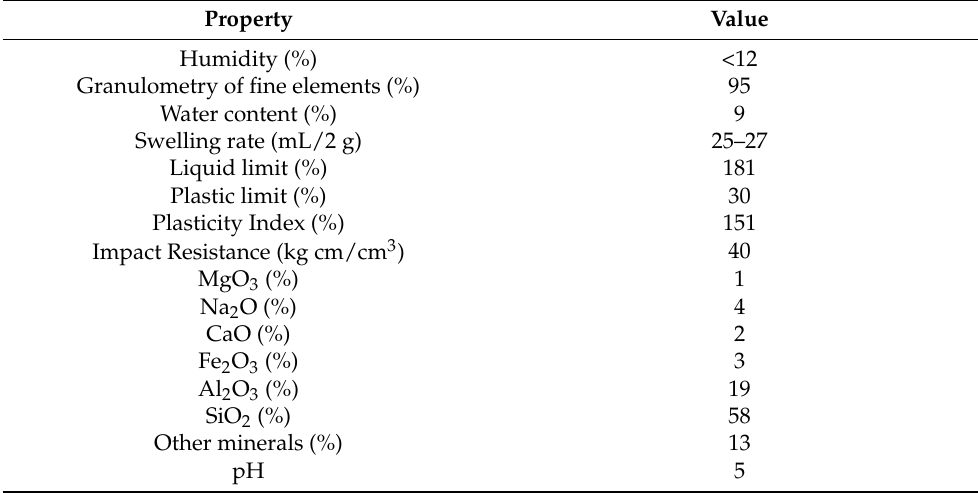
Table 1. Physic-Mechanical and Chemical Properties of Bentonite used